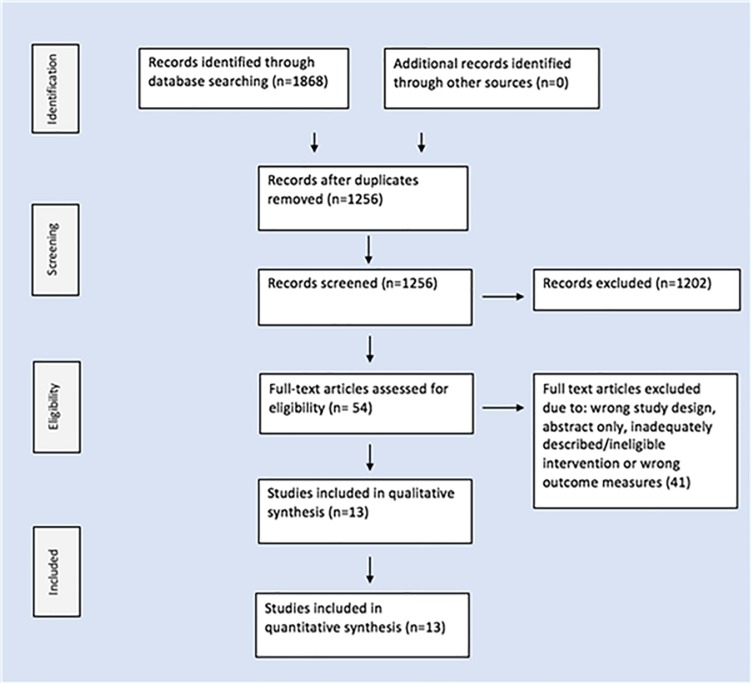
PRISMA flowchart.